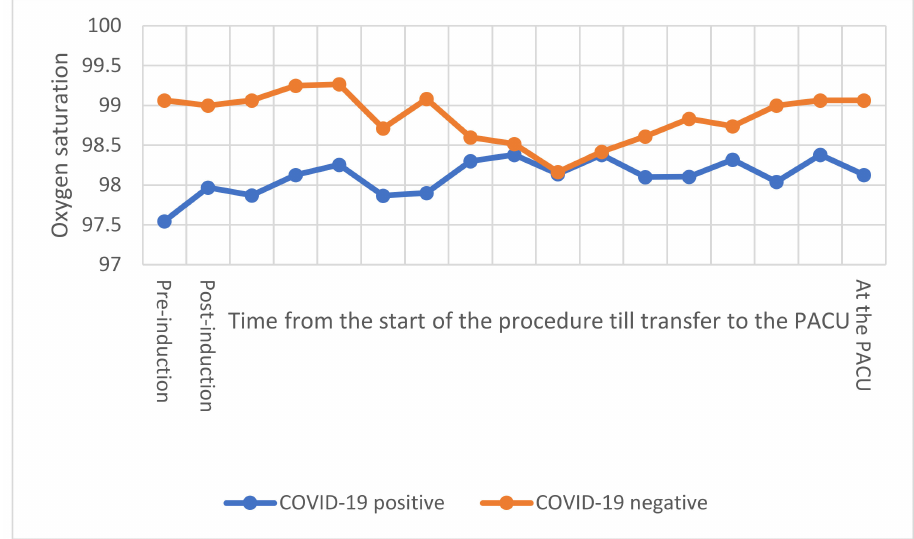
Figure 3. A comparison in oxygen (O 2 ) saturation between COVID-19 positive and negative patients. The x -axis represents the timing of O 2 saturation measurement. Intraoperatively, O 2 saturation was documented every 5 min until transfer to the PACU. The y -axis represents the O 2 saturation in percentage (%). PACU: post anesthesia care unit. Vital signs are presented along with comparison with COVID-19 positive group in Supplementary Table